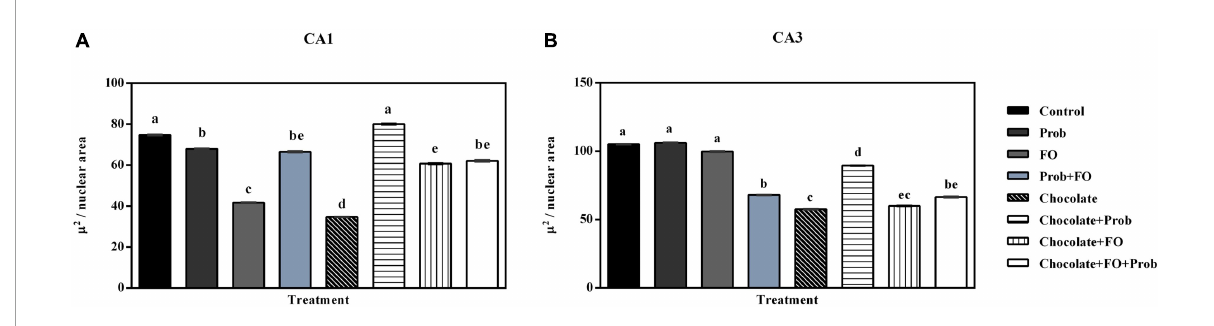
FIGURE6 Nuclear area in neurons in the hippocampus of the different treatment brain samples. Prob, probiotics; FO, fish oil. (A) Hippocampal CA1 region, (B) Hippocampal CA3 region. Different letters among bars indicate statistically significant differences between treatments by the LSD test ( p <